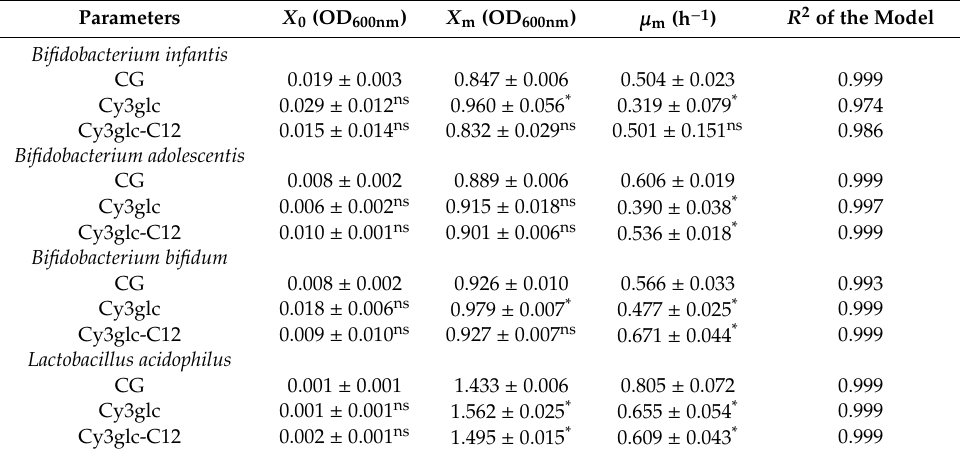
Table 3. Growth kinetic parameters of three Bifidobacteria and one Lactobacillus